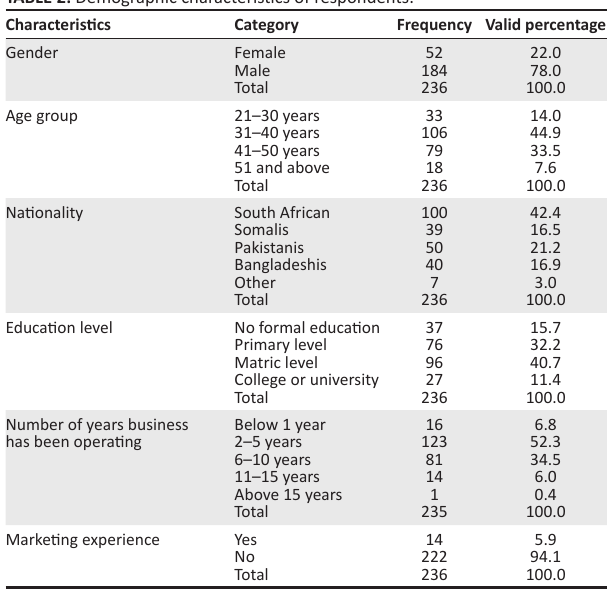
TABLE 2: Demographic characteristics of respondents.